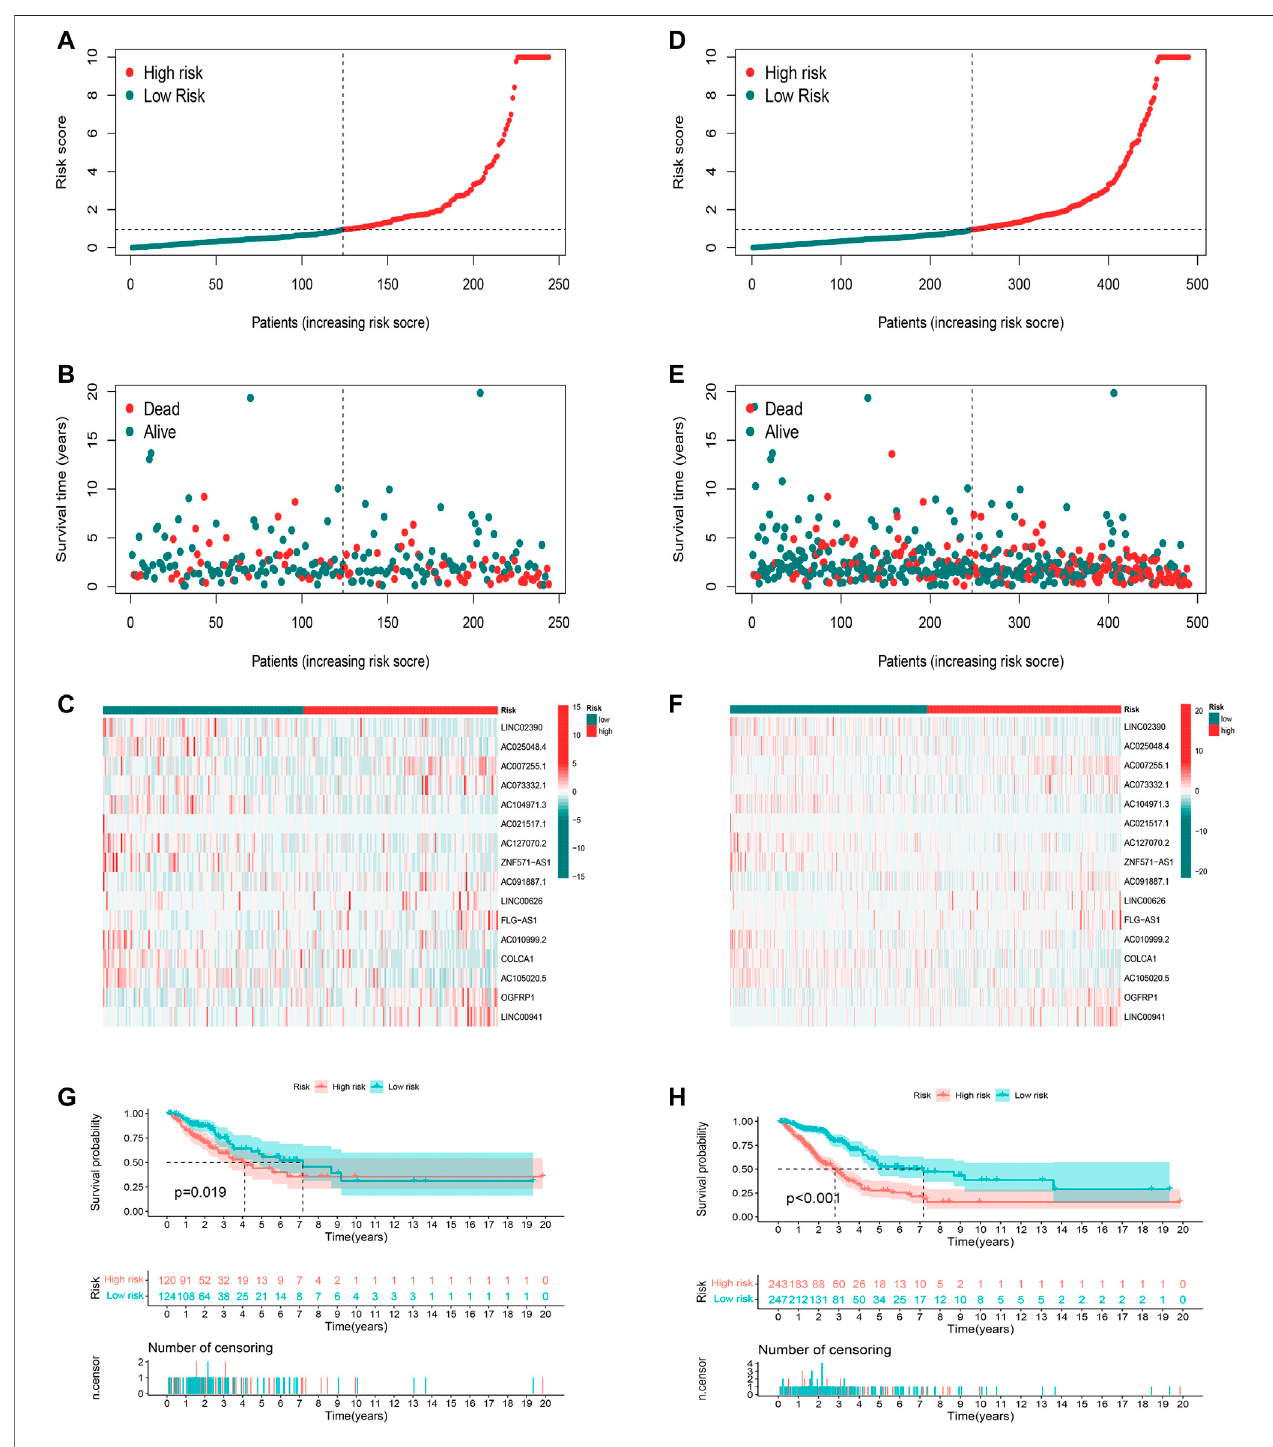
FIGURE 4 | Validation of the prognostic oxidative stress-related lncRNA signature. (A) Risk score, (B) survival status, and (C) heatmap for the testing set. (D) Risk score, (E) survival status, and (F) heatmap for the entire set. (G) Kaplan – Meier curve for the testing set. (H) Kaplan – Meier curve for the entire set.